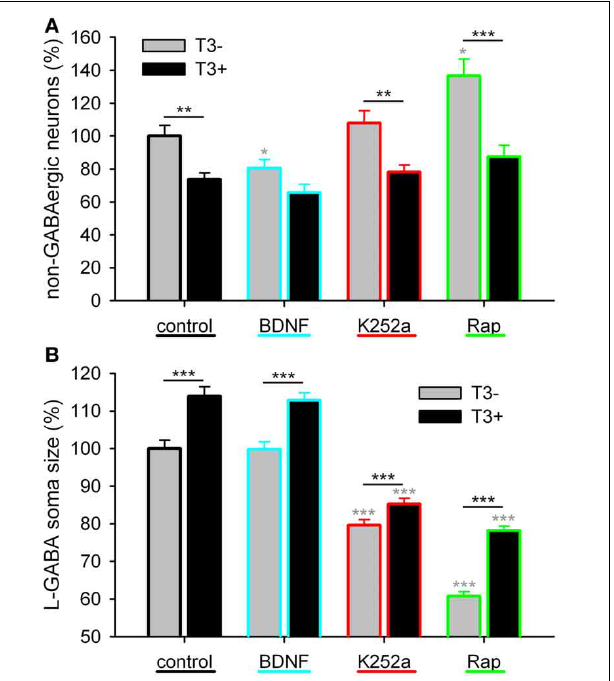
FIGURE 10 | Effect of trkB or mTOR signaling pathways on the T3-dependent development of non-GABA population (A) and GABAergic soma growth (B). Note that, on the non-GABA population, the T3 influence decreases in the presence of BDNF, and apparently increases with the blockade of mTOR by rapamycin (A) . The L-GABA population showed decreased soma sizes when growing without either T3, trkB or mTOR signaling (B) . Data normalized to the T3 − control